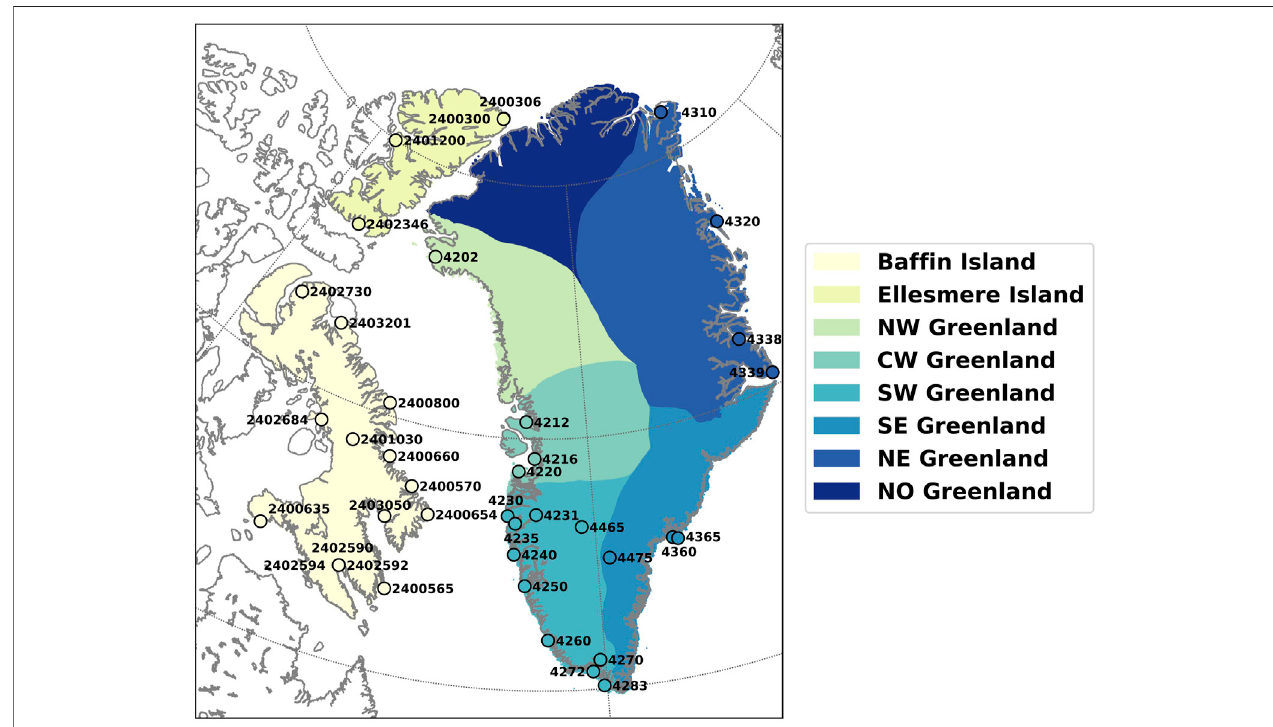
FIGURE 1 | Map of the study region. Coloured circles show station locations and identi fi cation numbers within each subregion.